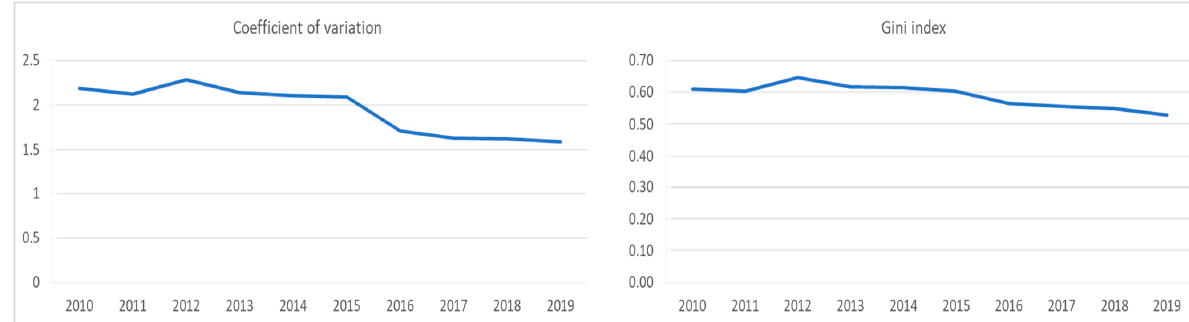
Figure 6. Spatial heterogeneity analysis of urban industrial land in the YRD.